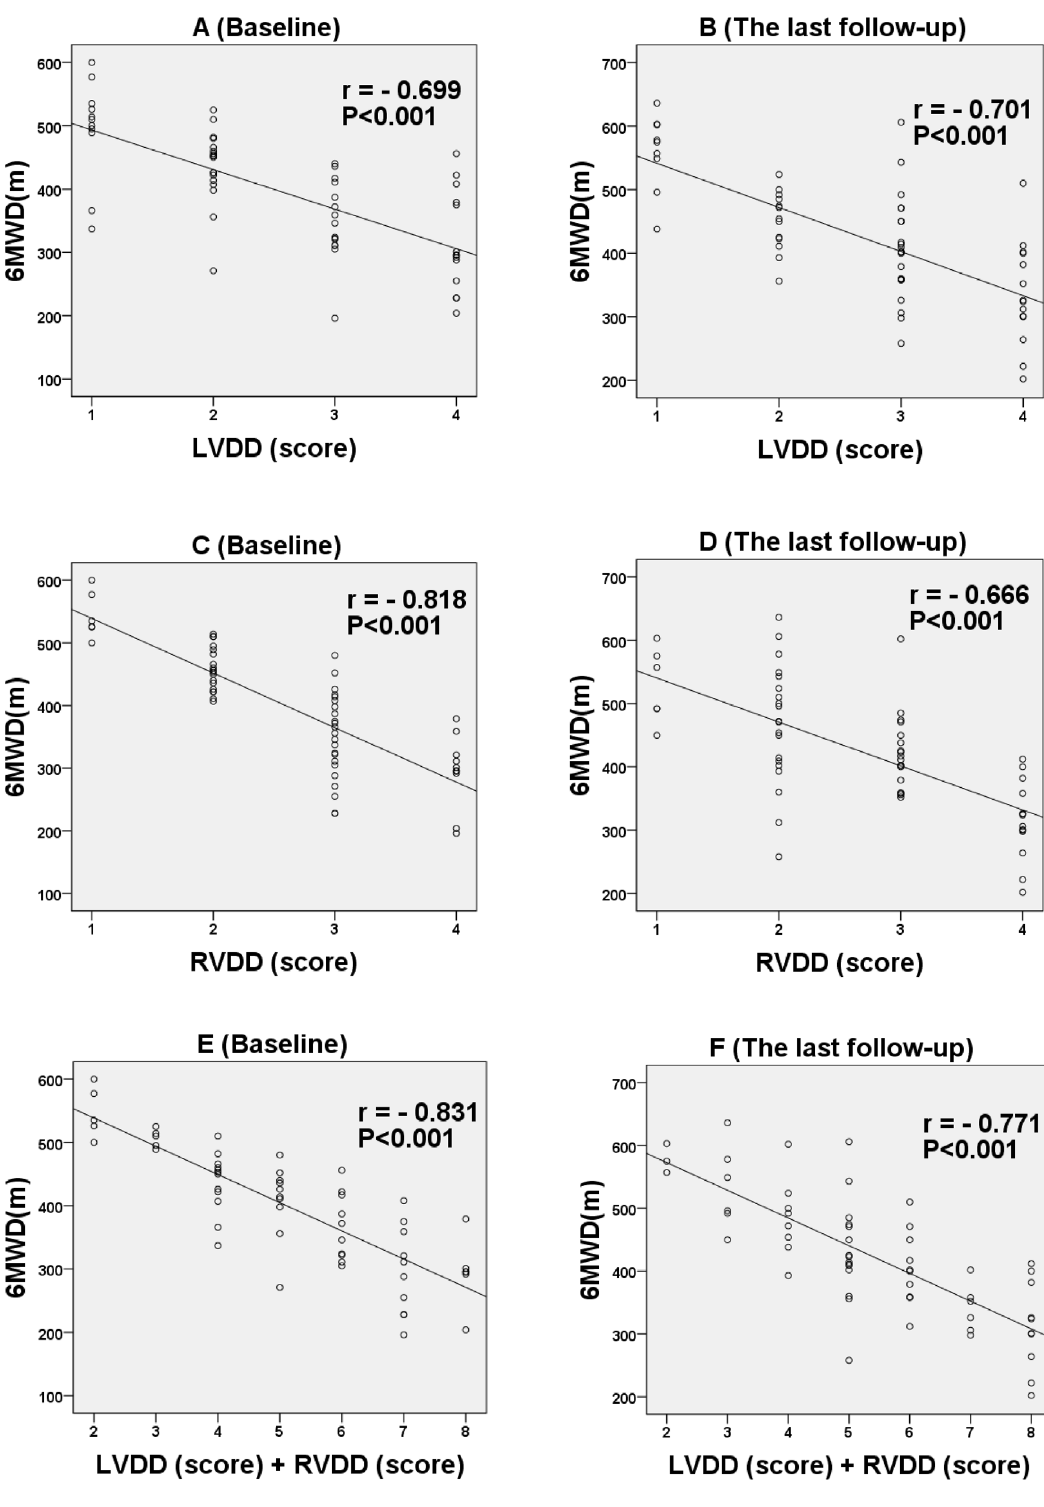
Fig. 3. The relationship between LVDD score, RVDD score, (LVDD + RVDD) score and 6MWD at baseline (A, C, E) and the last follow-up (B, D, F).